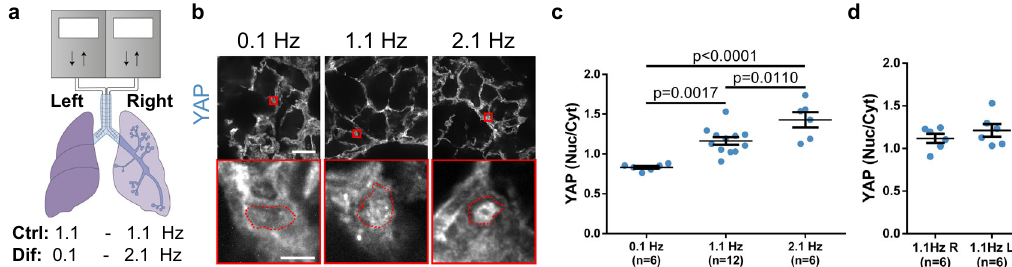
Fig. 5 Increasing rates of lung ventilation in vivo induce YAP nuclear localization. a Diagram of the rat lung ventilation setup, where each lung was independently cannulated and ventilated. Ventilation was either uniform at 1.1 Hz in both lungs (Ctrl) or differential with the left and right lungs ventilated at 0.1 and 2.1 Hz, respectively (Dif). Both conditions had the same ventilation volume. b YAP staining of rat lungs ventilated at 0.1, 1.1, and 2.1 Hz. Areas circled in red are magni fi ed below each image. In magni fi ed images, nuclear contours (as determined from Hoechst stainings) are shown in red. Scale bar is 50 µ m in top images, and 5 µ m in magni fi cations. c Quanti fi cation of YAP nuclear to cytoplasmic ratios for rat lungs ventilated with same tidal volume at 0.1, 1.1, and 2.1 Hz. Statistical signi fi cance was assessed with one-way ANOVA. d Quanti fi cation of YAP nuclear to cytoplasmic ratios for left and right rat